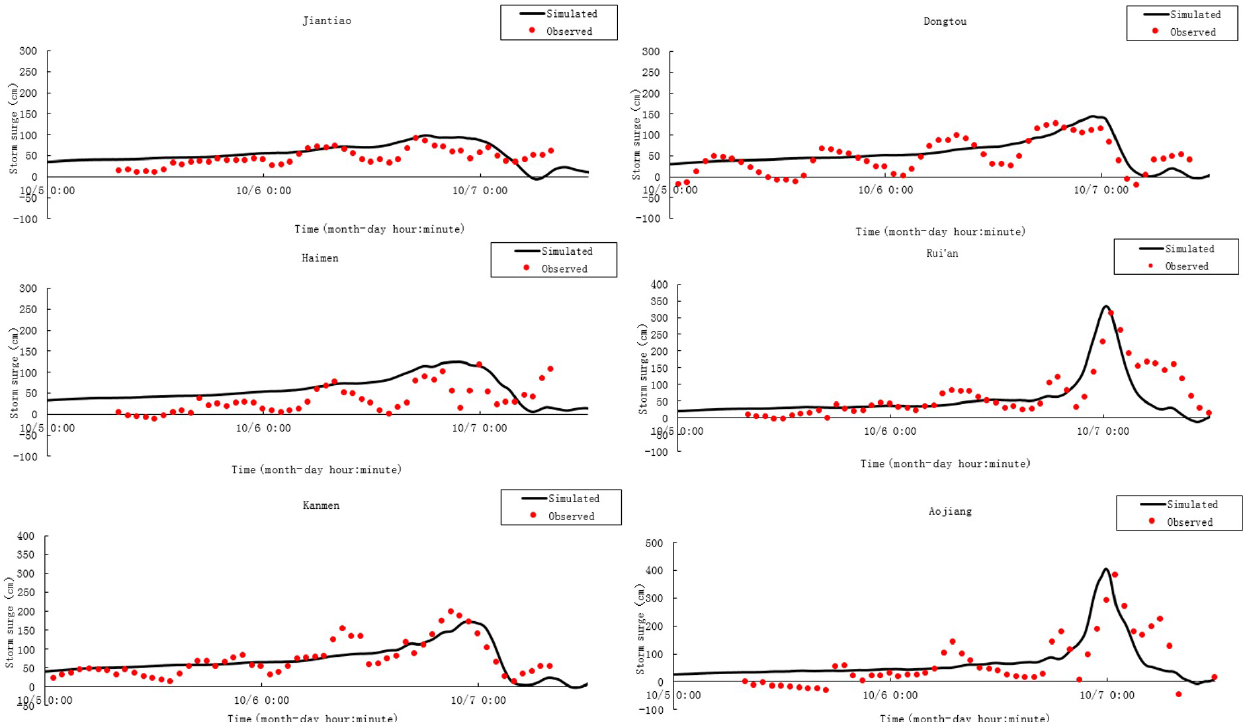
Figure 6. Verification of the storm surge for tidal stations affected by the storm surge caused by Typhoon Fitow (no.